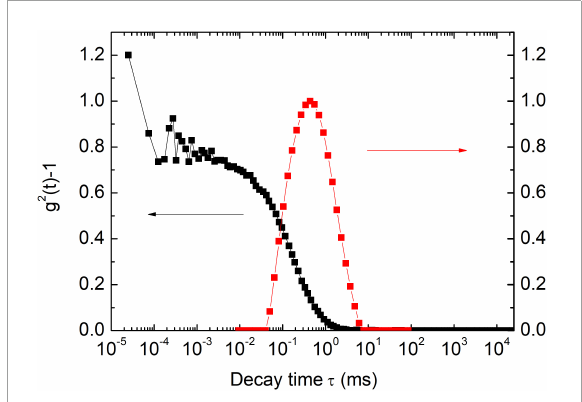
FIGURE2 Dynamic light scattering (DLS) autocorrelation function [g 2 (t)-1] for a typical sample (0.15 mol/L KCl) and its corresponding characteristic decay time